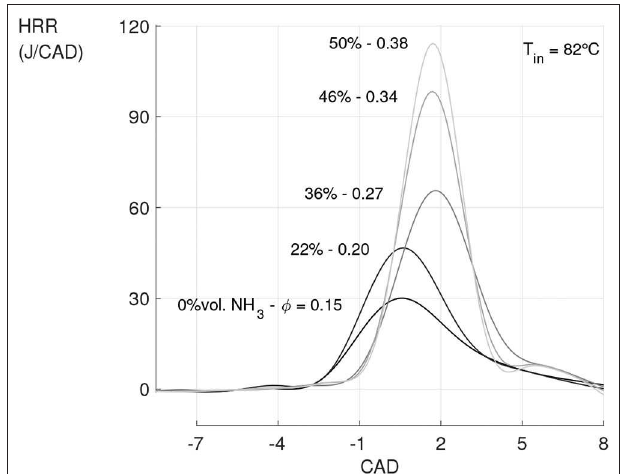
FIGURE 13 | Simply increasing the ammonia flow rate while maintaining the intake temperature and hydrogen loading constant (set #4) can lead to a constant combustion timing, although the load has been more than